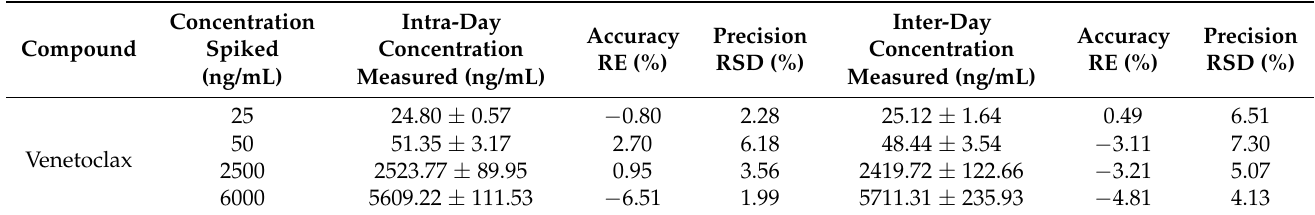
Table 2. Intra-and inter-day precision and accuracy of venetoclax (mean ± SD, n = 6).